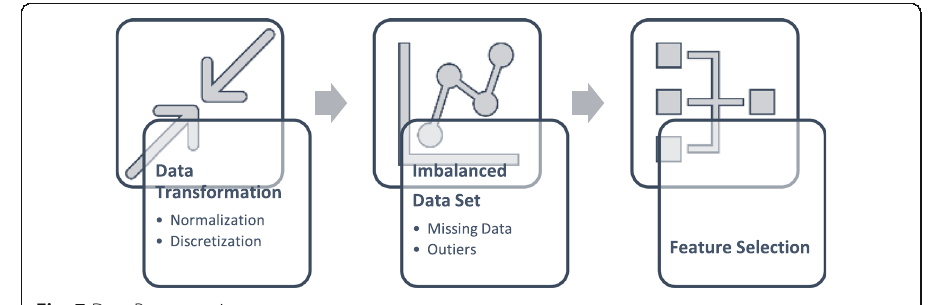
Fig. 7 Data Preprocessing